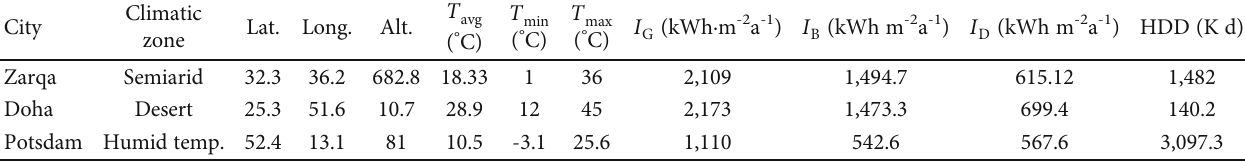
Figure 2: Block diagram of the research methodology ’ s Table 1: Climatic properties for the three locations [19, 20].